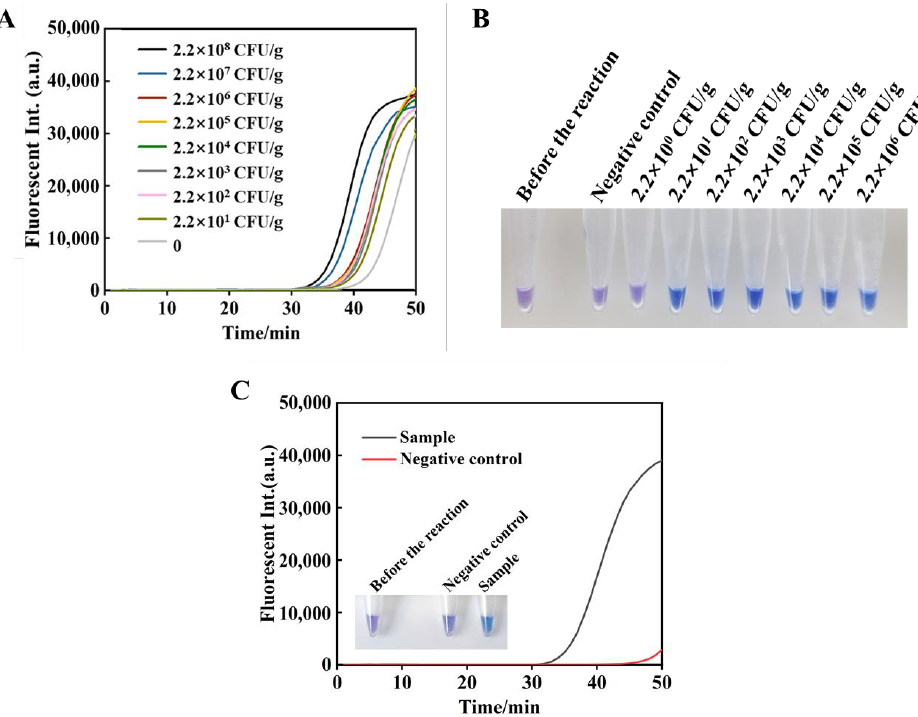
Figure 4. Target detection for artificially contaminated oyster samples. ( A ) Real-time fluorescence analysis. [dNTPs] = 1.4 mmol/L, [primers] = 0.8 µ mol/L, [MgSO 4 ] = 6 mmol/L, 3.2 U Bst 2.0 DNA Poly- analysis. [dNTPs] = 1.4 mmol/L, [primers] = 0.8 μmol/L, [MgSO 4 ] = 6 mmol/L, 3.2 U Bst 2.0 DNA merase, 1 × isothermal amplification buffer at 65 ◦ C for 50 min. ( B ) Visual detection of V. parahaemolyticus Polymerase, 1 × isothermal amplification buffer at 65 °C for 50 min. ( B ) Visual detection of V. para- haemolyticus by hydroxynaphthol blue (HNB). [HNB] = 120 μmol/L, amplification time is 40 min. by hydroxynaphthol blue (HNB). [HNB] = 120 µ mol/L, amplification time is 40 min. ( C ) Detection ( C ) Detection result of the unknown sample. result of the unknown